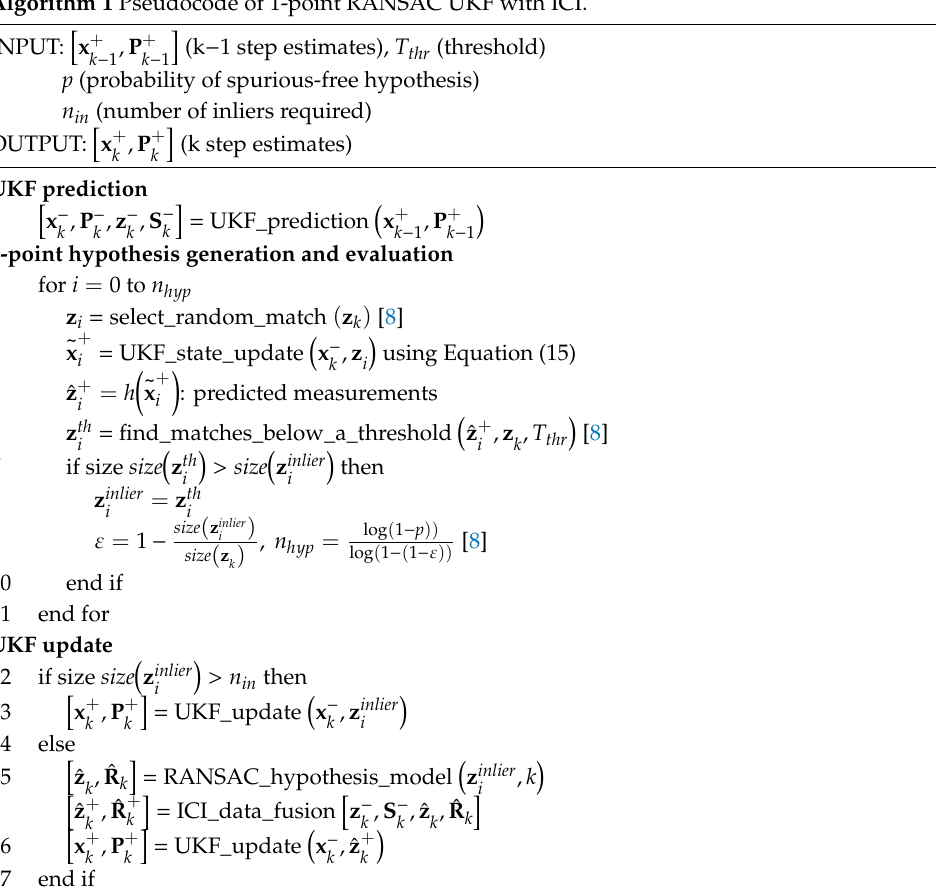
Algorithm 1 Pseudocode of 1-point RANSAC UKF with